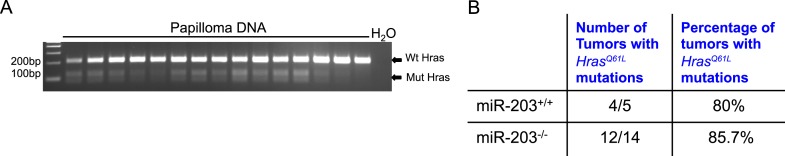
The HrasQ61L mutation is common in both miR-203+/+ and miR-203−/− tumors.(A) Representative end-point PCR followed by XbaI digestion. The HrasQ61L allele produces 120 bp and 87 bp product, whereas wild-type produces a 207-bp product (B) Table with quantification of genotyping results. non-significant p > 0.05, chi-squared test.